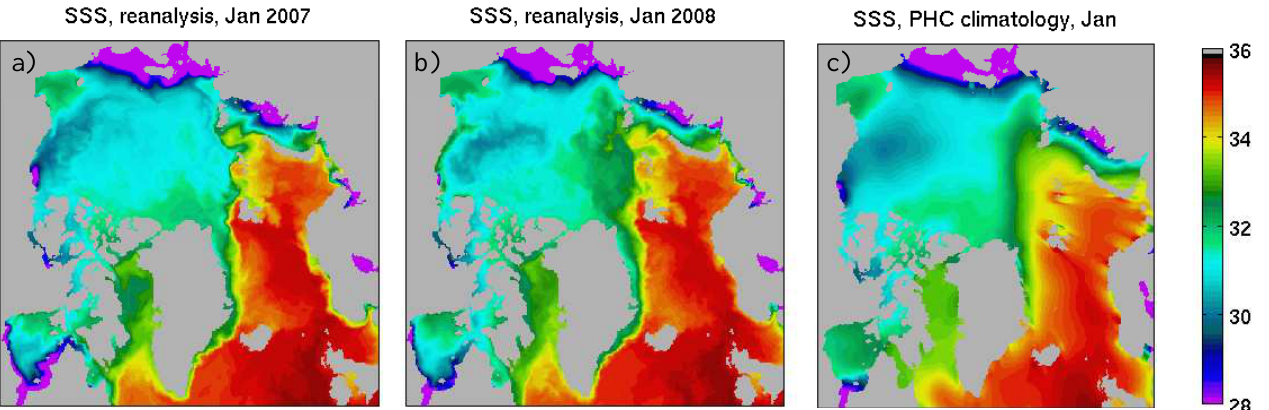
Fig. 14. Mean monthly SSS: (a) for January 2007 by TOPAZ4; (b) January 2008 by TOPAZ4; (c) for January from PHC climatology.